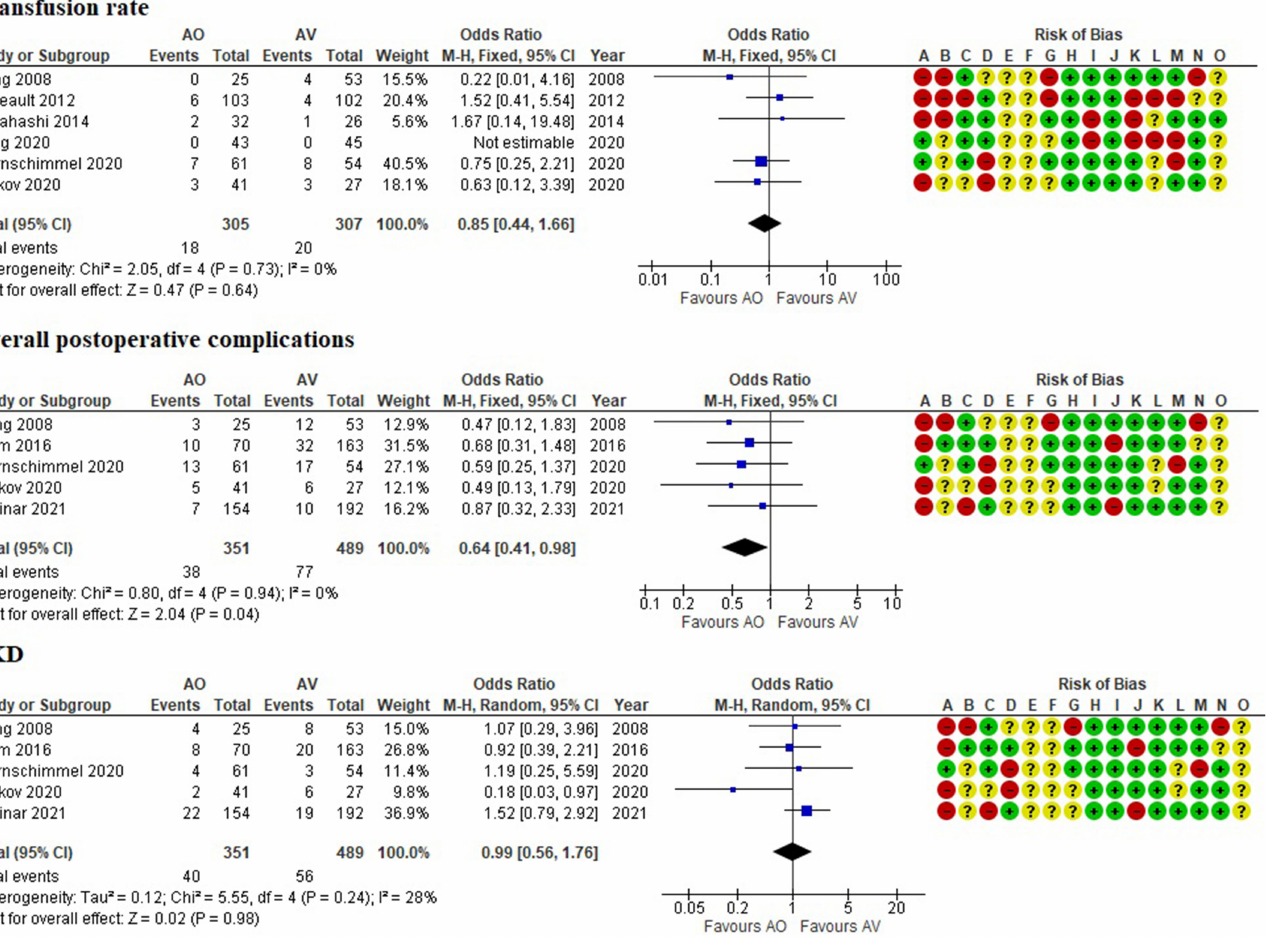
7. Meta-analysis of transfusion rate, overall postoperative complications, and progression to CKD. (A) Random